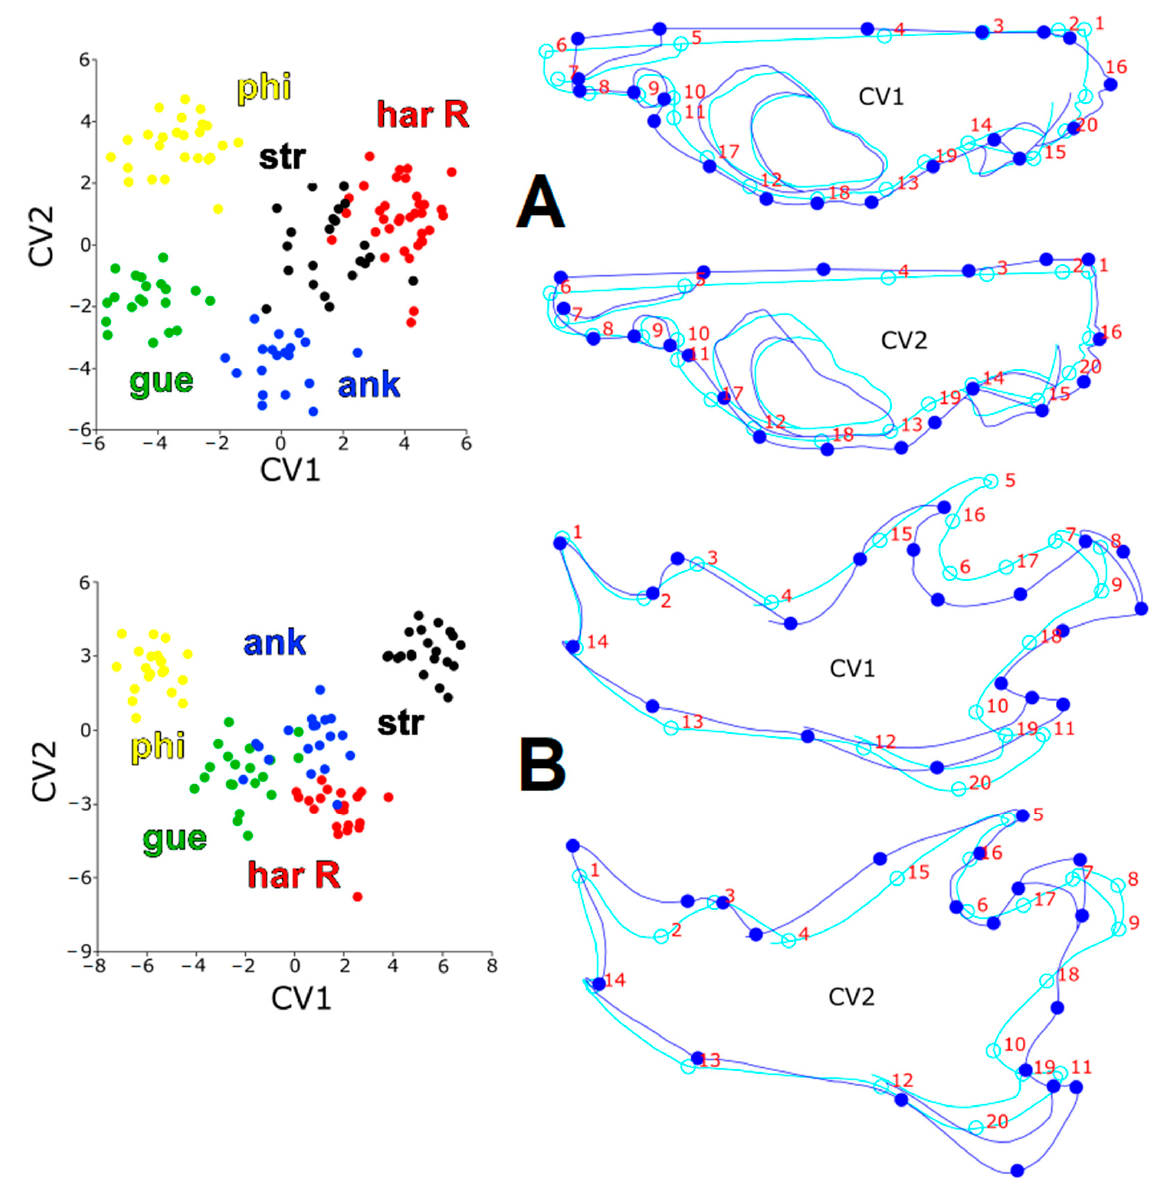
Figure 4. Scatter plots of the CVA (on the left) and positive directional shape changes of CV1 and CV2 (on the right) in the cranial ( A ) and mandibular ( B ) datasets among five vole forms in the “guentheri” group. Blue dots indicate landmarks after shape deformation; red numbers indicate landmark numbers; the scale factor for deformation visualization: 30.0.